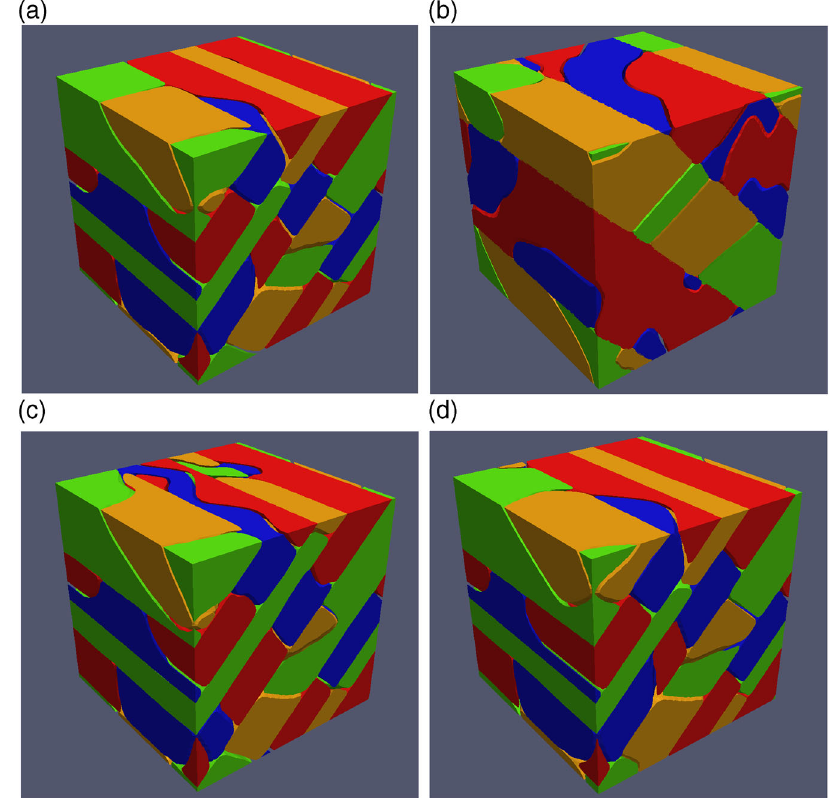
Fig. 2 Polytwin structures consisting of two orientational variants of martensite are obtained from phase fi led dynamics using transformation pathway of a LP, b NP1, c NP2, and d NP3 as de fi ned in Table 1. Note that in each martensite layer, two domains (represented by different colors ) in antiphase relationship (corresponding to plus and minus sign in OP) are